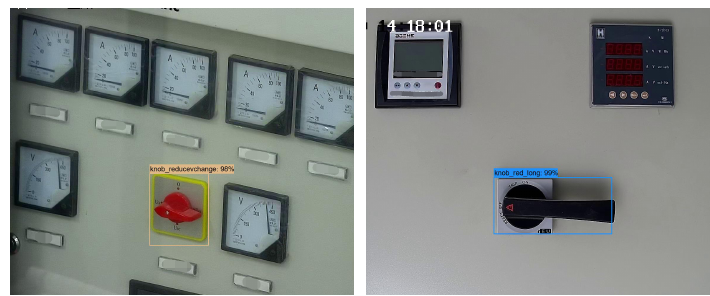
Figure 9. Original cabinet panel images collected on substation.